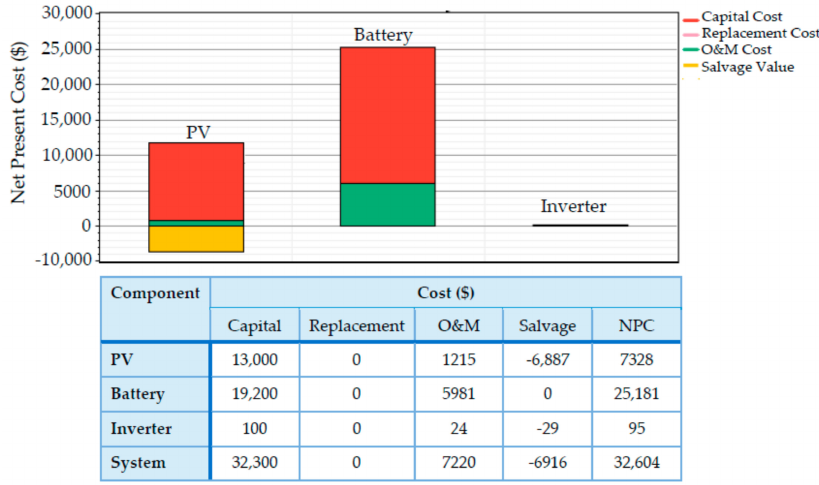
Figure 7. Summary of the net present cost for the system's components.